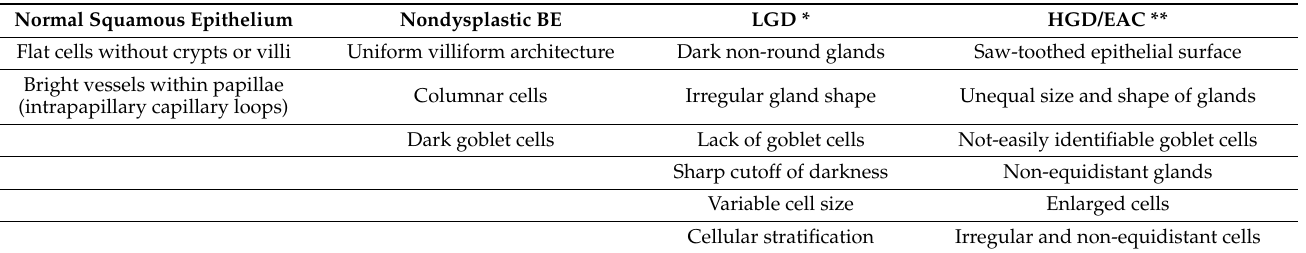
Table 1. CLE diagnostic criteria for nondysplastic BE and dysplastic BE/EAC (table created